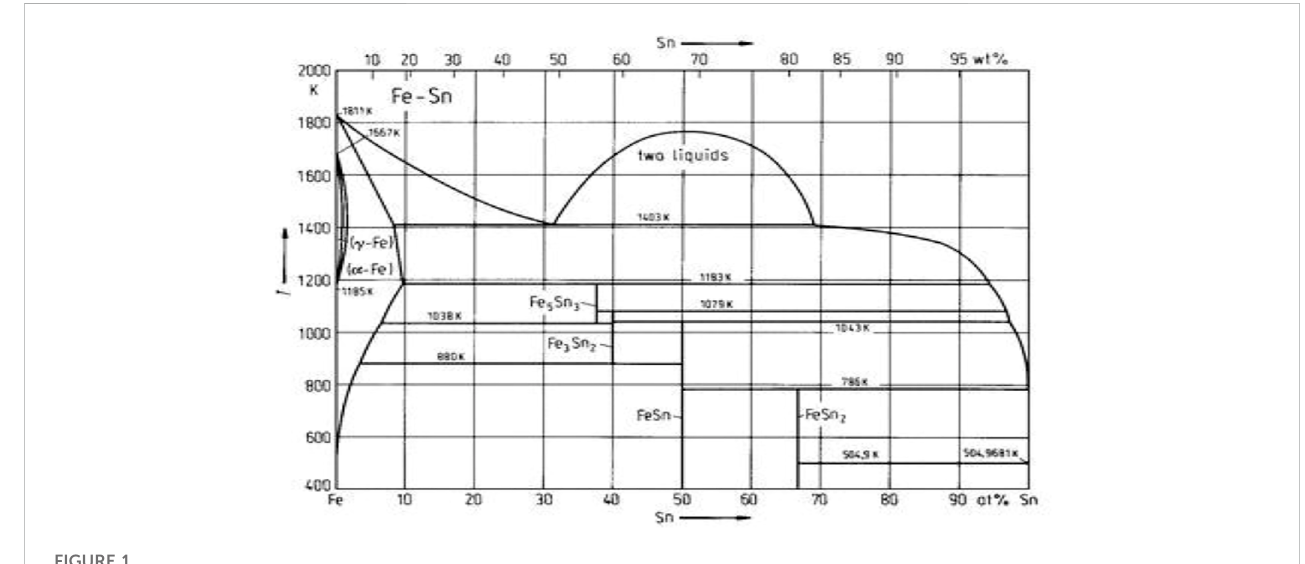
FIGURE 1 Fe – Sn phase diagram.